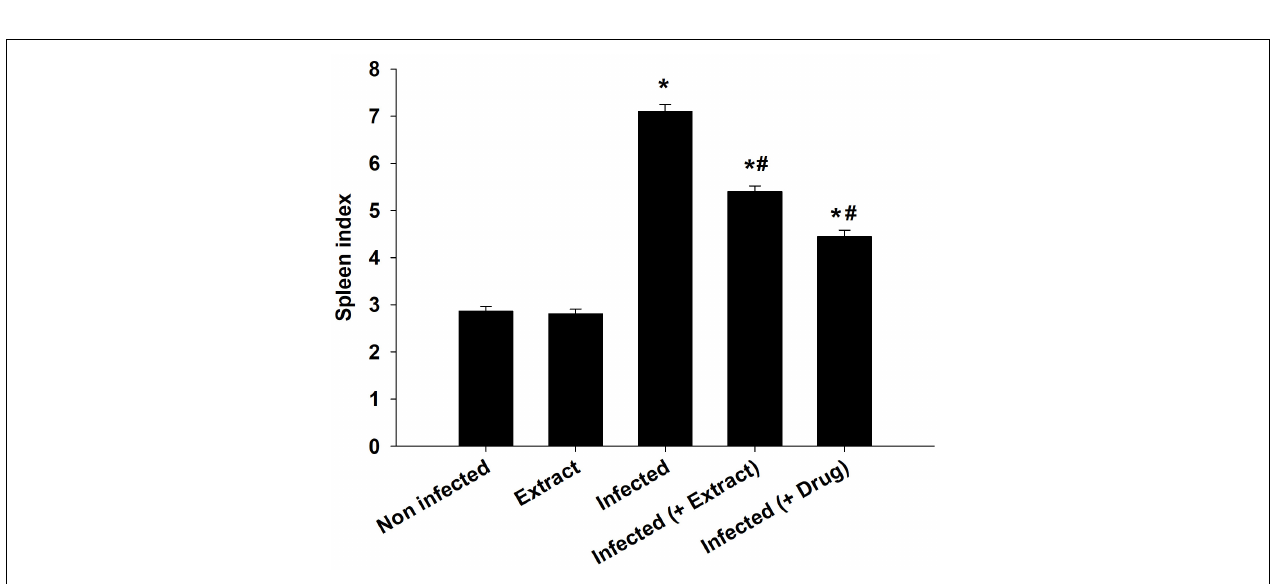
FIGURE 3 | E. camaldulensis induced change in spleen index of mice infected with T. evansi. * p ≤ 0.01, significance against the control group. # p ≤ 0.01, significance against the infected group.